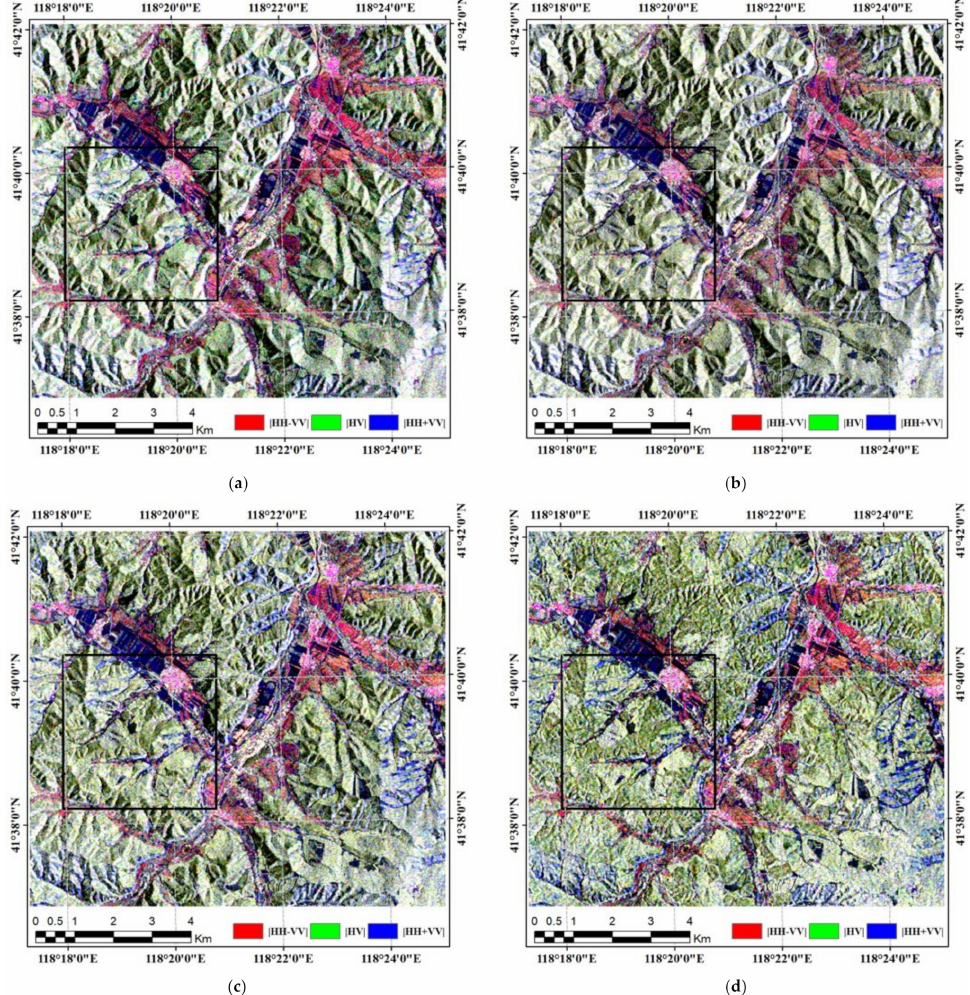
Figure 8. The PolSAR Pauli RGB after each correction step: ( a ) GTC (i.e., no correction); ( b ) POA correction; ( c ) POA + ESA correction; ( d ) POA + ESA + AVE